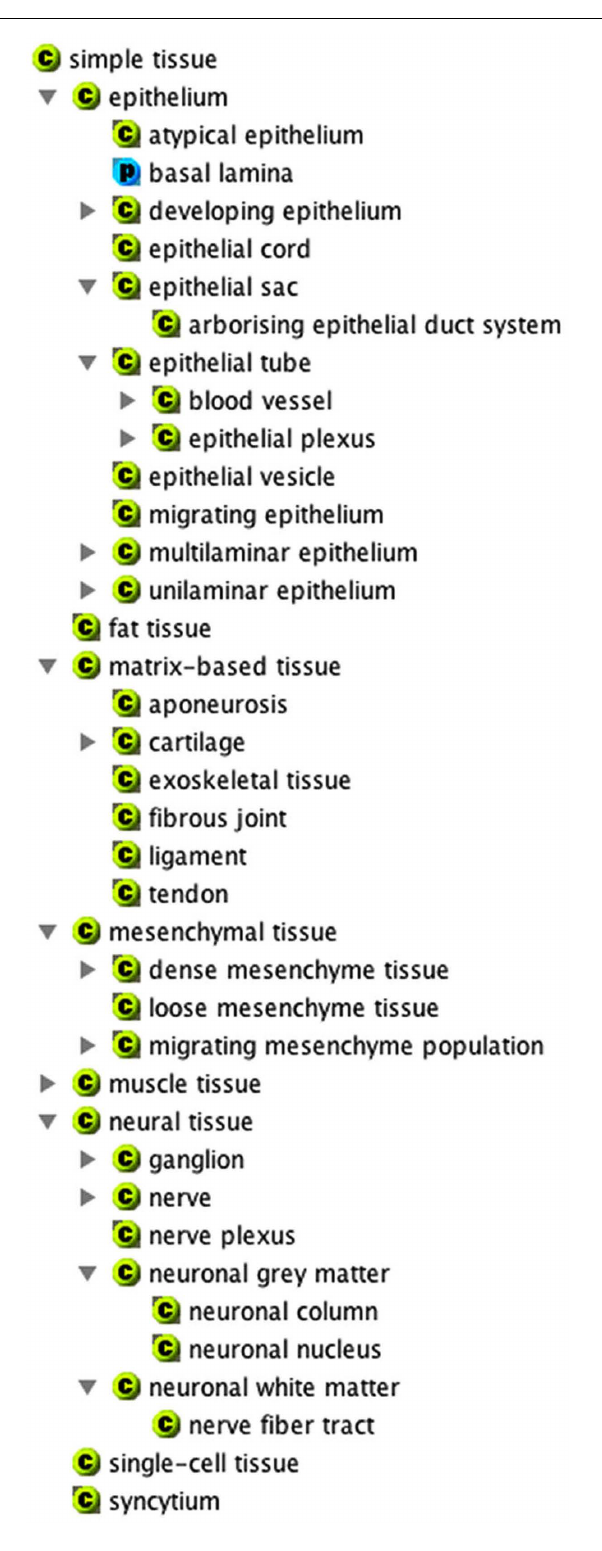
FIGURE 3 |The simple-tissue hierarchy of theAEO shown in the COBrA browser. All top and secondary levels terms are shown together with some tertiary level ones.